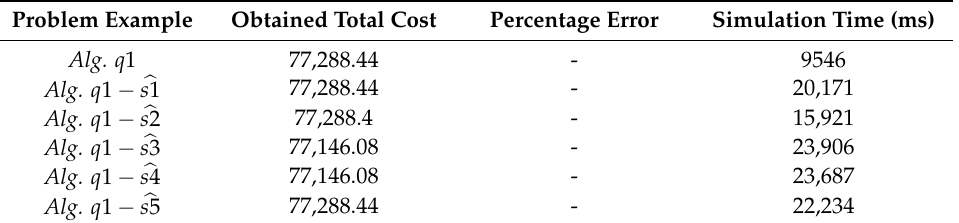
Table 12. Obtained results for irregular network GIr-5 (suboptimal cost).